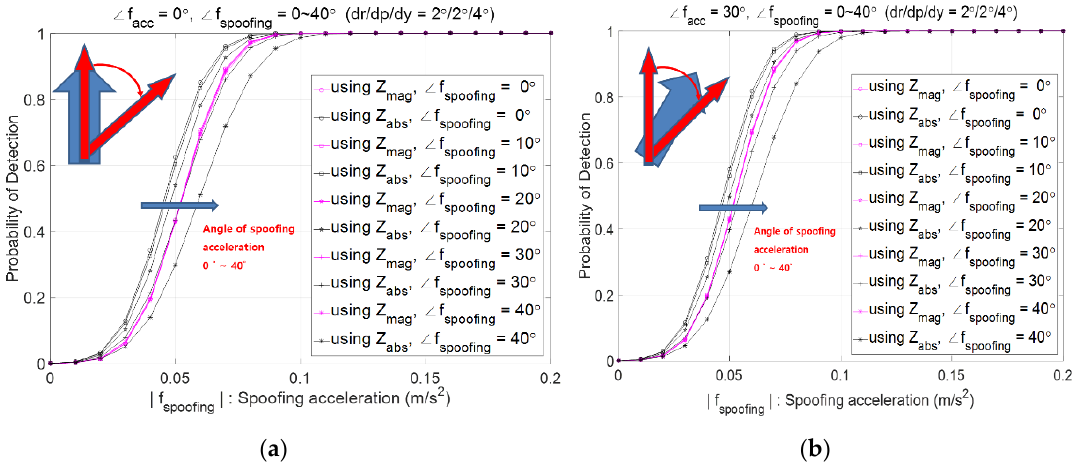
(cid:12) (cid:12) (cid:12) (cid:12) (cid:12) f acc (cid:12) = 0.6 m/s 2 ,